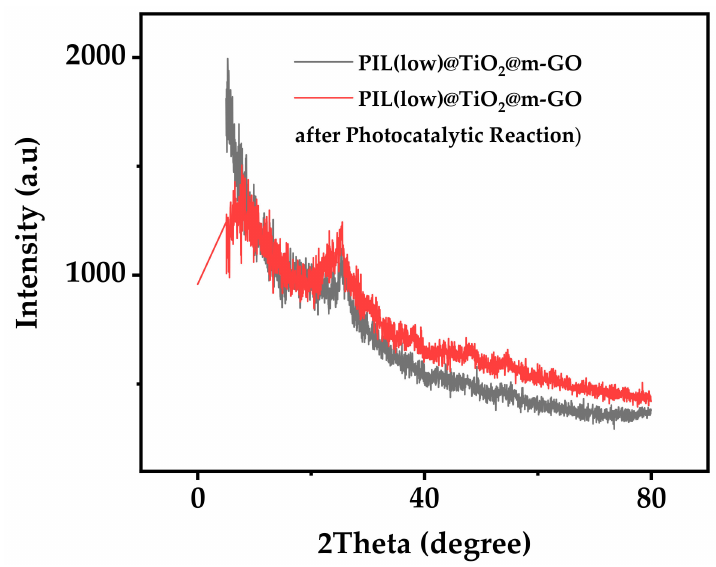
Figure 11. XRD pattern of PIL(low)@TiO 2 @m-GO after the photocatalytic reaction.